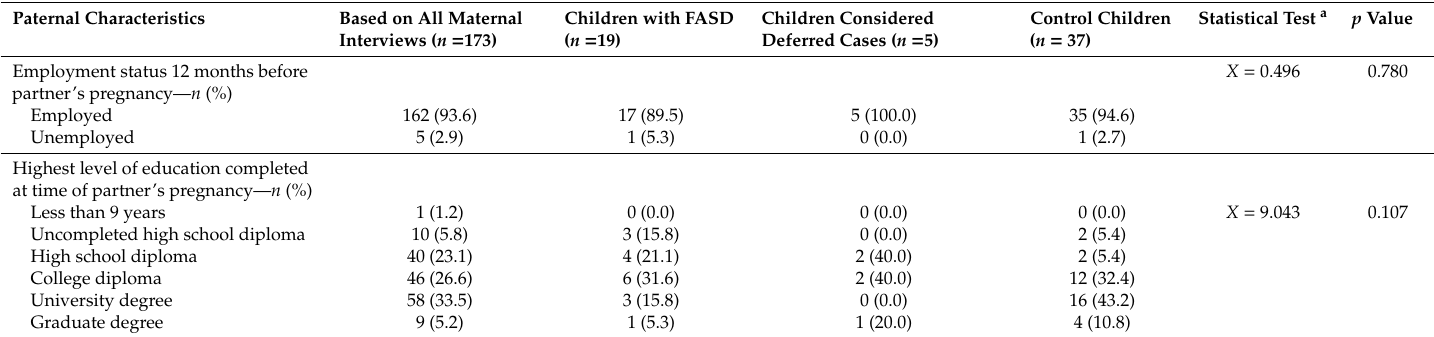
Table 2. Paternal demographic characteristics of children with FASD, and control children.